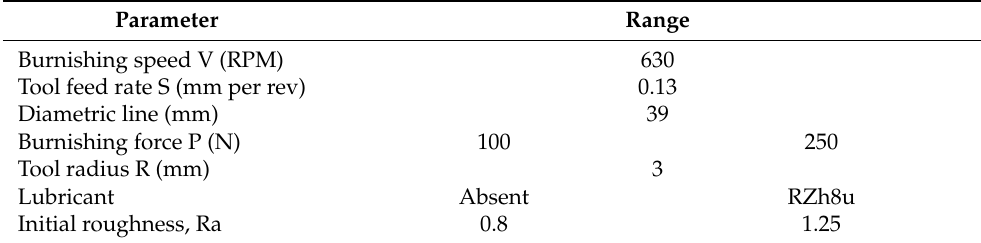
Table 3. Experimental